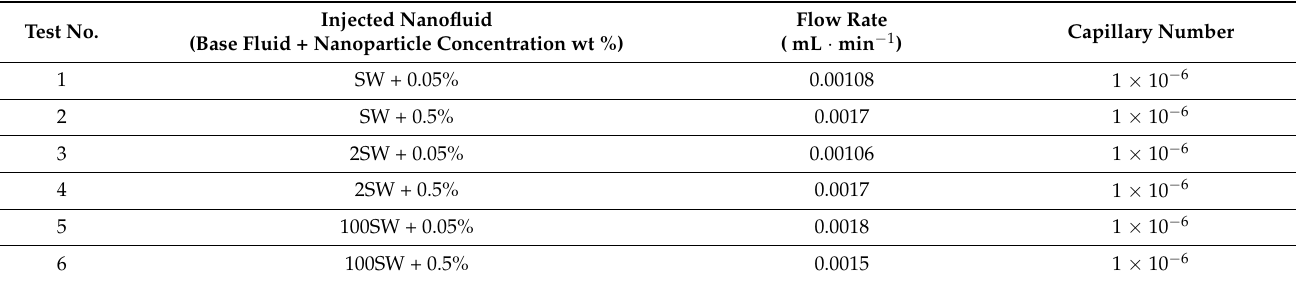
Table 4. List of oil displacement experiments in the present